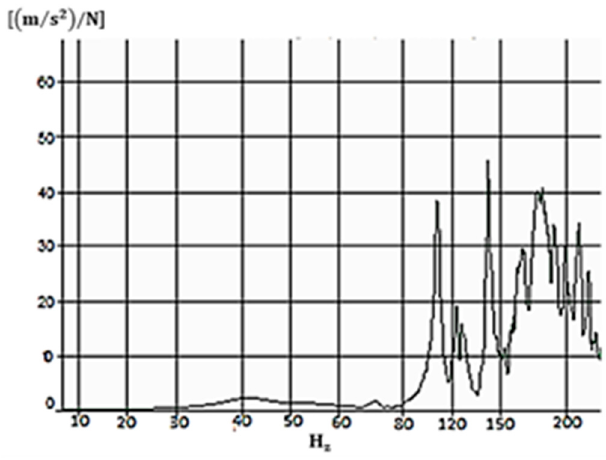
Figure 3. Frequency response function for [0]10 specimen.